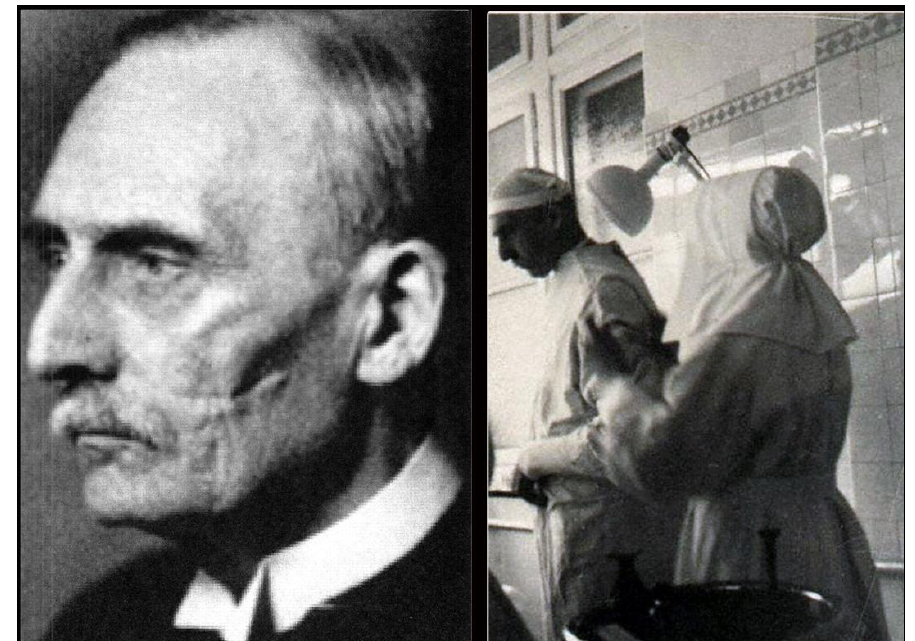
Figure 1: Profile photograph of Conrad Ramstedt (Left). Professor Ramstedt is get- ting ready to perform a pyloromyotomy (Right). (Original source of these photo- graphs and copyright status are unknown - Reproduced under “Fair use” doc- trine for non-profit academic